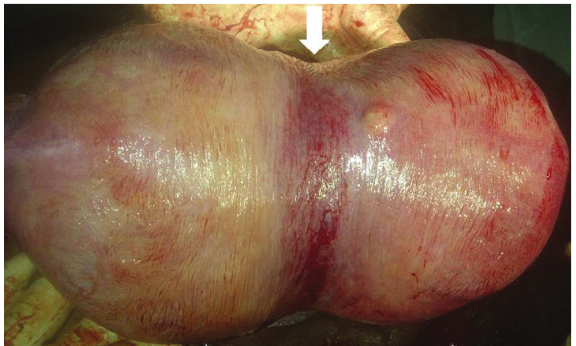
Figure 1: Bicornuate morphology with the typical fundal indenta- tion (arrow).